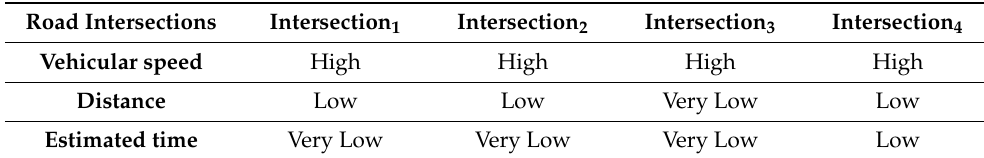
Table 2. Fuzzy rules for the road intersections.